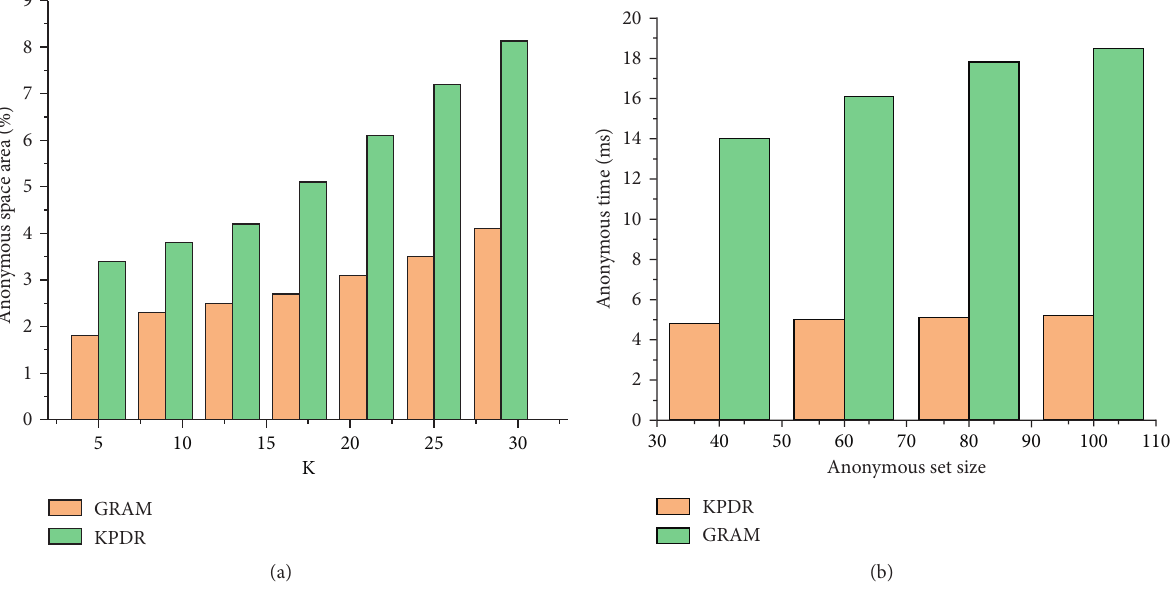
Figure 4: Comparison of anonymous space and anonymous time. (a) Anonymous space area comparison. (b) Anonymous time